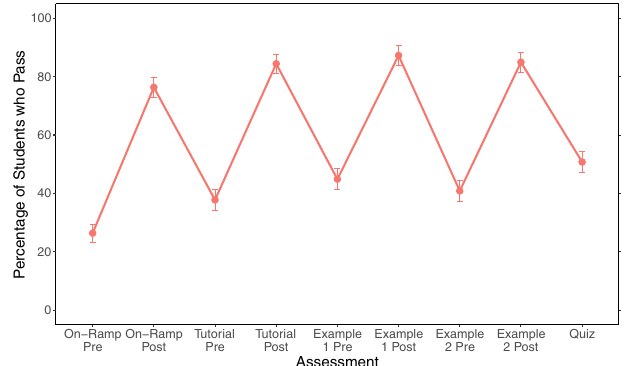
FIG. 1. An example of a zigzag plot, adapted from Ref. [10]. Each point represents the passing rate of students either before ( “ Pre ” ) or after ( “ Post ” ) being given access to the instructional material in each module. Passing rates in the Post stage of a module are cumulative with Pre stage attempts. See Sec. II D for more